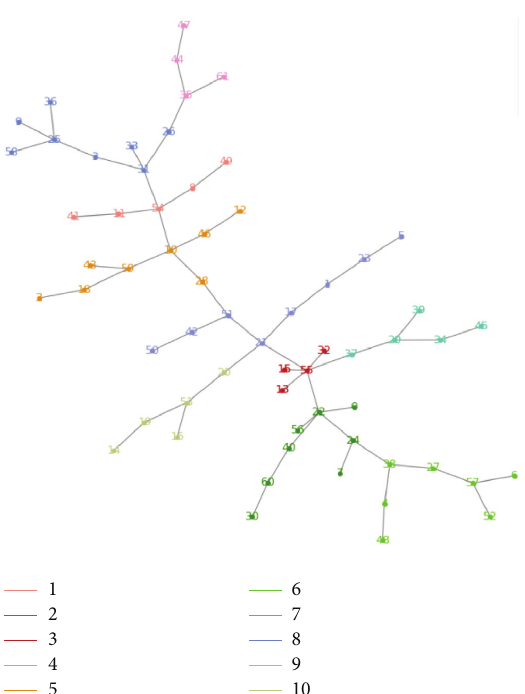
Figure 7: The community of energy stock price jump from October 2016 to April 2017.